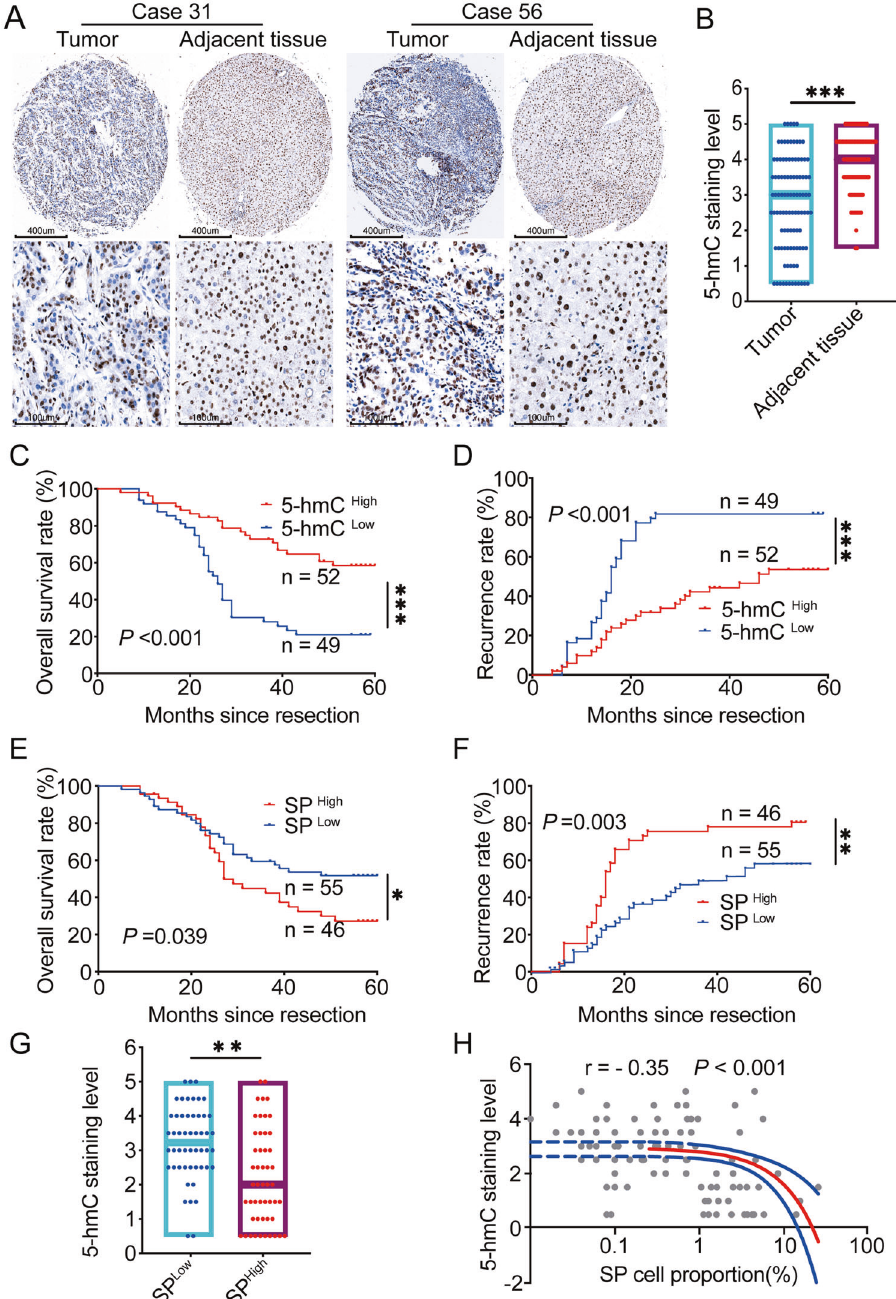
Fig. 1 Prognostic signi fi cance of 5-hmC level and the proportion of SP cells in HCC. A Representative IHC staining images of differential 5-hmC levels in 101 HCC and adjacent nontumor tissues. B The staining level of 5-hmC in HCC tumor tissue was signi fi cantly weaker than paired adjacent normal tissue; Wilcoxon matched-pairs signed-rank test, *** P < 0.001. C Kaplan – Meier estimate of overall survival rate of 101 HCC patients with different levels of 5-hmC; Log-rank test, *** P < 0.001. D Kaplan – Meier estimate of cumulative recurrence rate of 101 HCC patients with different levels of 5-hmC; Log-rank test, *** P < 0.001. E Kaplan – Meier estimate of the overall survival rate of 101 HCC patients with different proportions of SP cells; Log-rank test, P = 0.039. F Kaplan – Meier estimate of cumulative recurrence rate of 101 HCC patients with different proportions of SP cells; Log-rank test, P = 0.003. G The staining level of 5-hmC in SP high groups was signi fi cantly weaker than in SP low ; Wilcoxon rank-sum test, P = 0.003. H Estimation of correlation between 5-hmC staining level and the proportion of SP cells in tumor tissues; Spearman rank correlation, r = − 0.35, P <